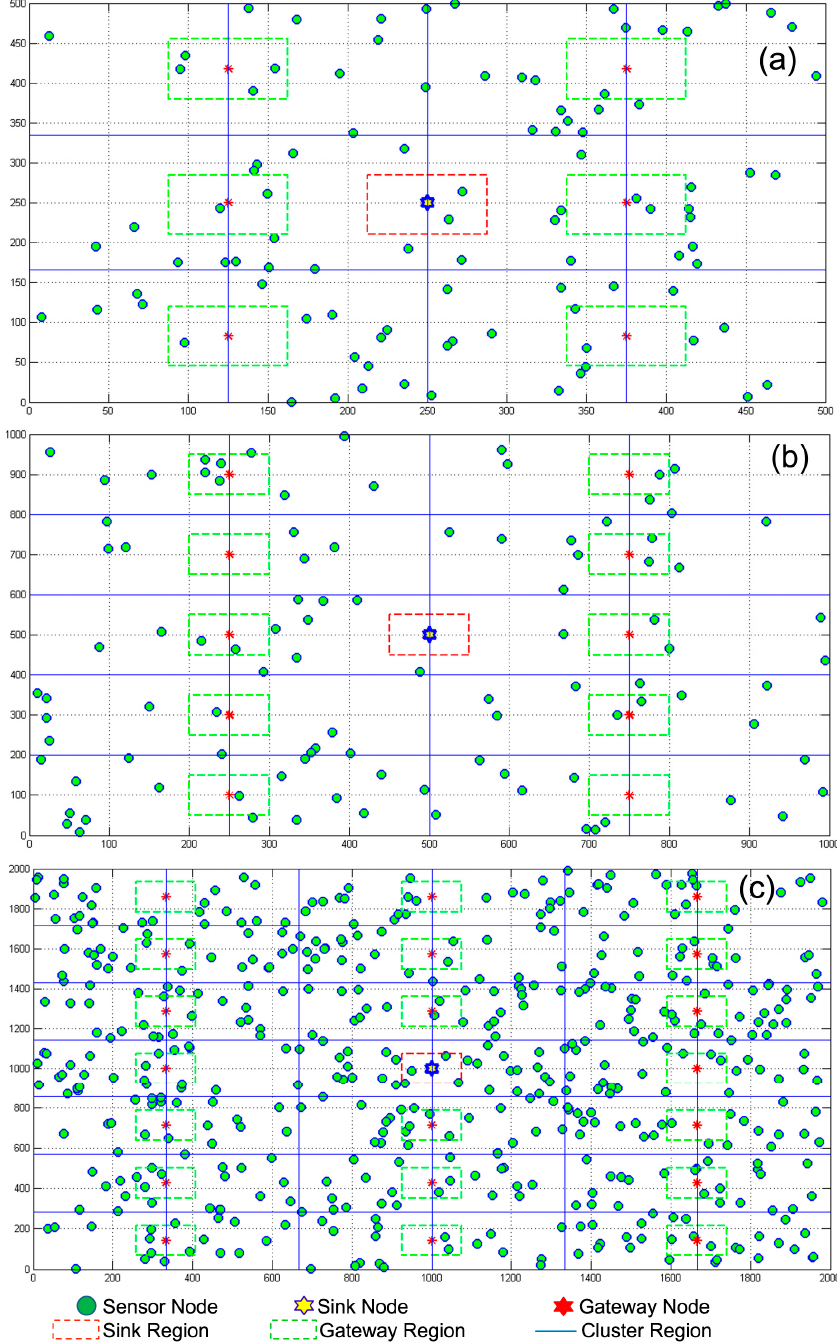
Figure 2. MATLAB view of the MGBEHA protocol in ( a ) 500 × 500 m 2 area, ( b ) 1000 × 1000 m 2 area, and ( c ) 2000 × 2000 m 2 area.